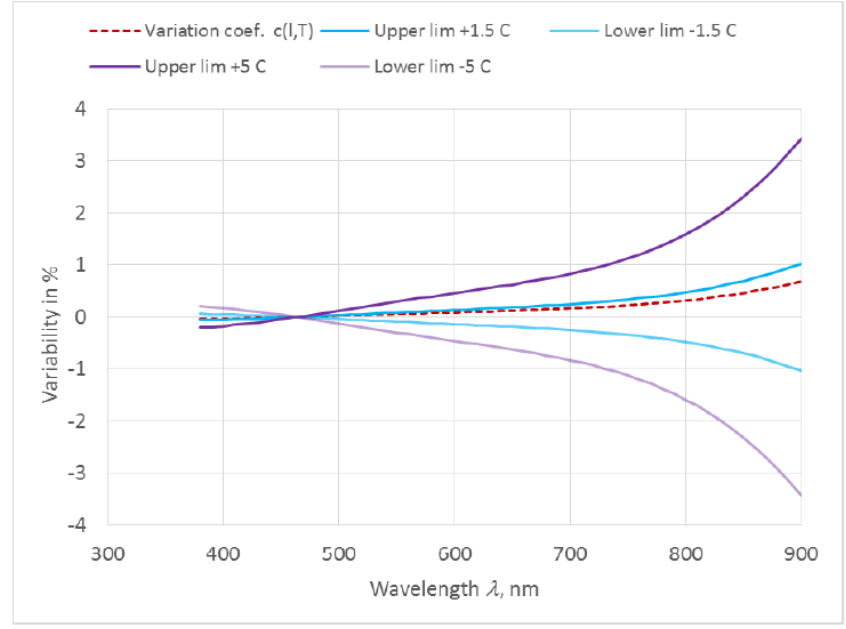
Figure 6. Variation in calibration coefficients as a function of wavelength for a range of temperatures for a RAMSES instrument, based on